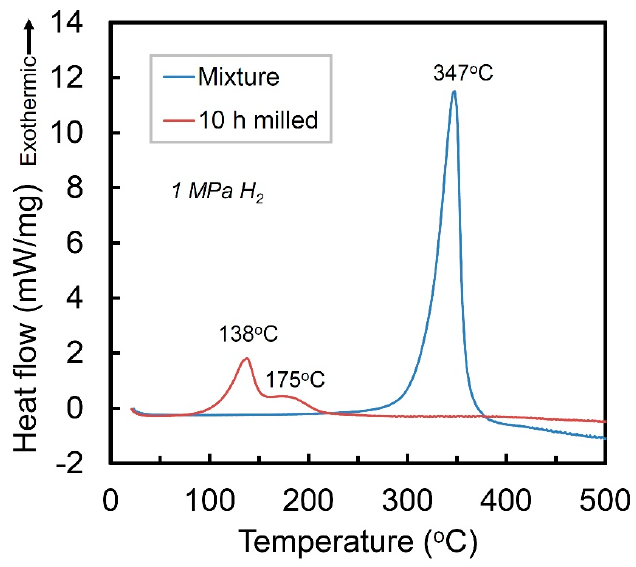
Figure 3. High-pressure DSC curves of the Ti+V+C mixture and the 10 h-milled Ti 50 V 50 -10% C alloy in 1 MPa hydrogen.